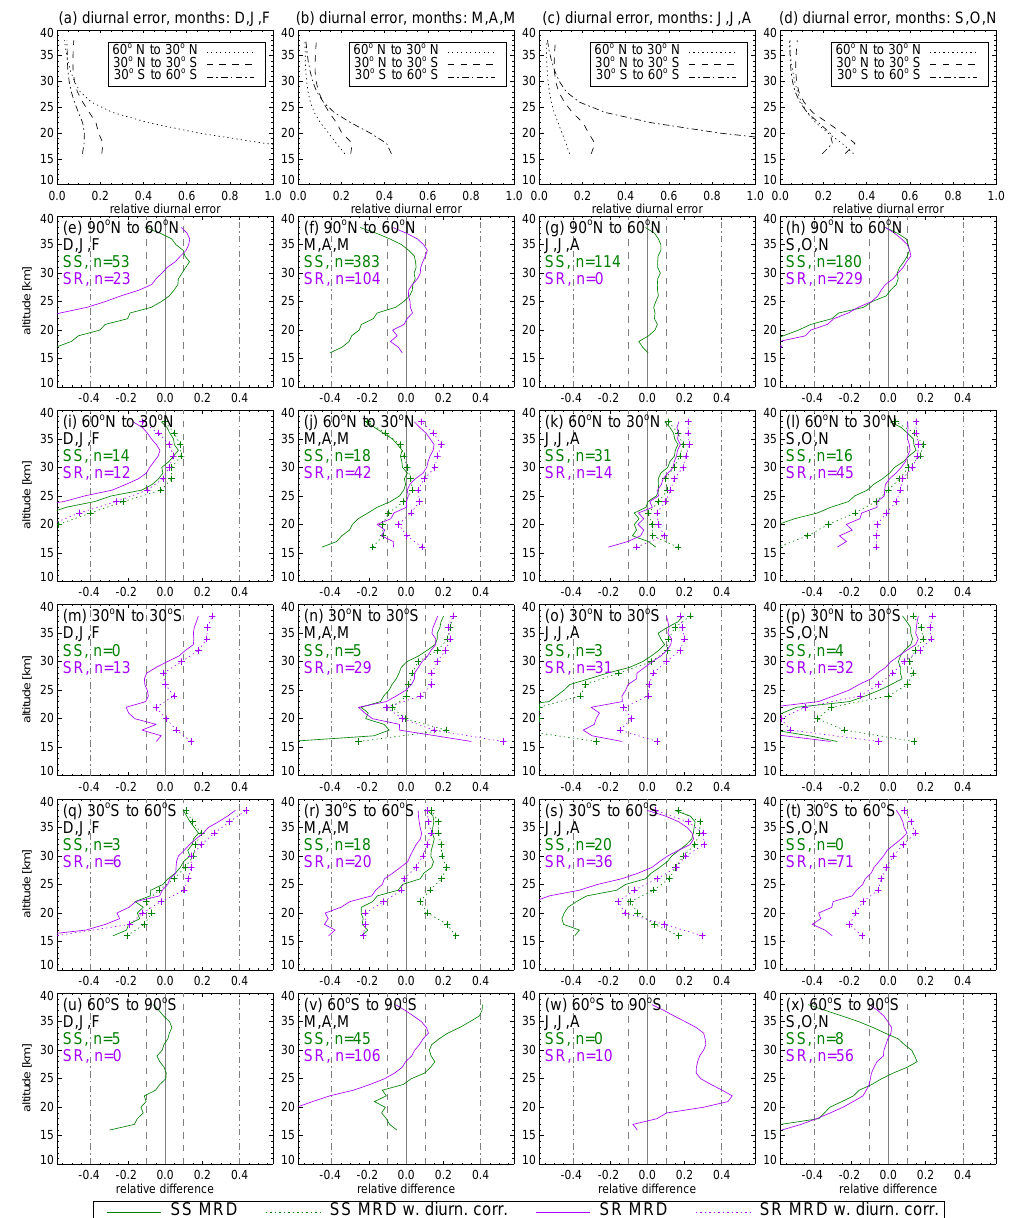
Fig. 16. For the latitude regions and seasons investigated in Fig. 15, the relative diurnal error for ACE-FTS measurements is estimated and averaged in panels (a) to (d) . Panels (i) to (t) show estimates of how this error influences the MRD between photochemically corrected ACE-FTS and SCIAMACHY limb NO 2 amounts. The solid green lines shows the MRD of photochemically corrected NO 2 sunset profiles from ACE-FTS without the diurnal effect error with SCIAMACHY results, and the green dashed line with the diurnal effect error. The same calculations are performed for sunrise measurements, with MRD values shown as violet solid lines, and violet dashed for MRD corr values with considering the diurnal effect